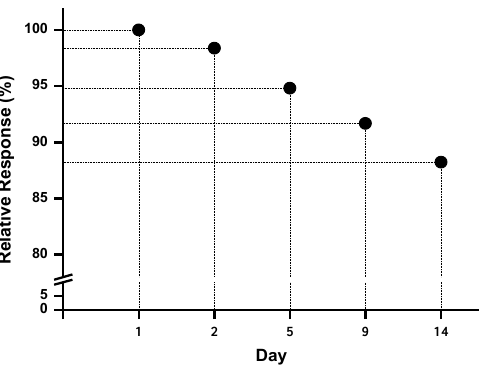
Figure 4. Relative response obtained according to the CP-Jen100 storage time. Analysis performed at 0.07 mM catechol solution in PBS 0.1 M (pH 7.0).